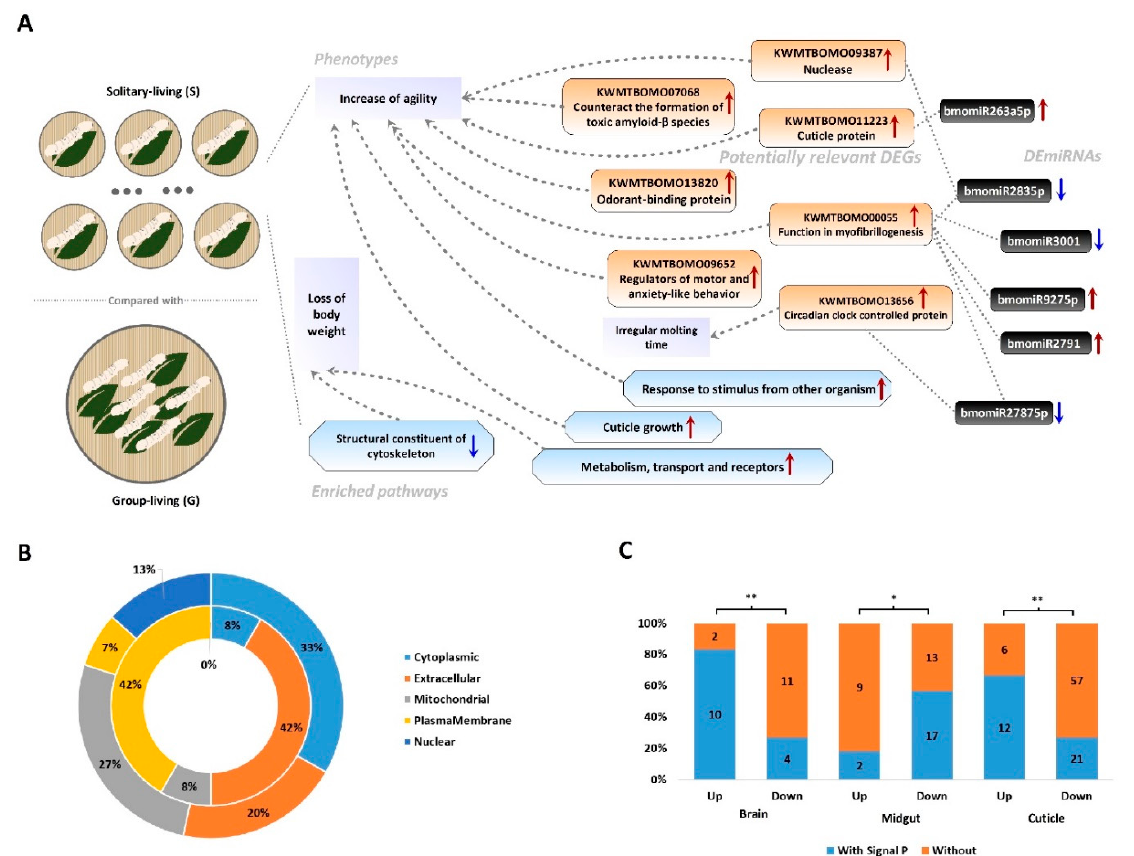
Figure 5. Transcriptome and miRNA analysis results. ( A ) is a predicted association network of the phenotypes induced by solitary living, potentially relevant DEGs, DEmiRNAs and enriched pathways. Red up-arrows denote up-regulation in solitary-living silkworms compared to group-living counterparts, while blue down-arrows denote down-regulation. DEGs, DEmiRNAs and enriched pathways are in boxes with different shapes and background colors. Dotted lines with arrows denote predicted contributions of DEGs or enriched pathways to phenotypes. Predicted associations between DEmiRNAs and DEGs are also indicated by dotted lines. The network is constructed based on Figure S8-S10 and Table S5-S9. ( B ) is the distribution of cell locations of DEGs up-regulated (inner cycle) and down-regulated (outer cycle) in the brain of solitary silkworms. ( C ) is the number/ratio of DEGs with signal peptides (Signal P) in brain, midgut and cuticle. Statistics are performed by Chisq test. ‘*’ denotes p -value < 0.05 and ‘**’ denotes p -value < 0.01.